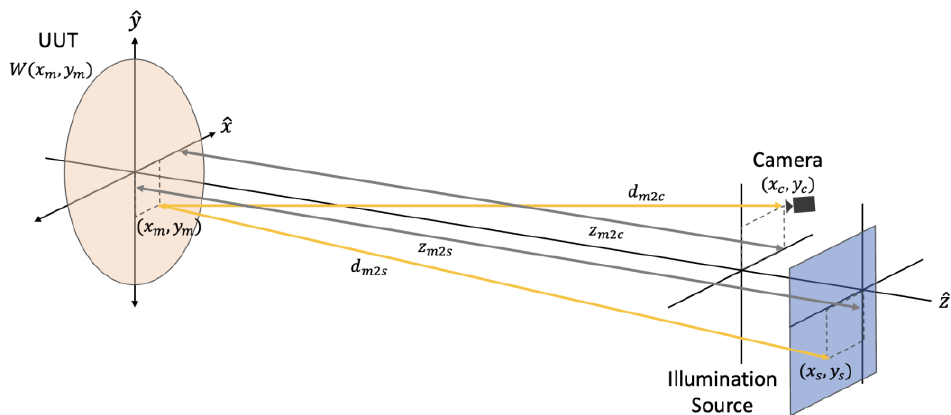
Figure 2. Between an illumination source, a camera, and a UUT, the law of specular reflection is satisfied. Here, the direction ˆ z is parallel to the optical axis of a spherical optic, the direction ˆ y in the tangential meridional plane, and the direction ˆ x in the sagittal plane. The coordinates y m , y s , and y c represent the y-coordinates of the mirror, source, and a pinhole camera as related by the law of specular reflection. d m 2 s and d m 2 c represent the absolute distances between the mirror and screen and mirror and camera, and z m 2 s and z m 2 c represent the distances of these physical locations along the direction ˆ z . W ( x m , y m ) is the sag of the